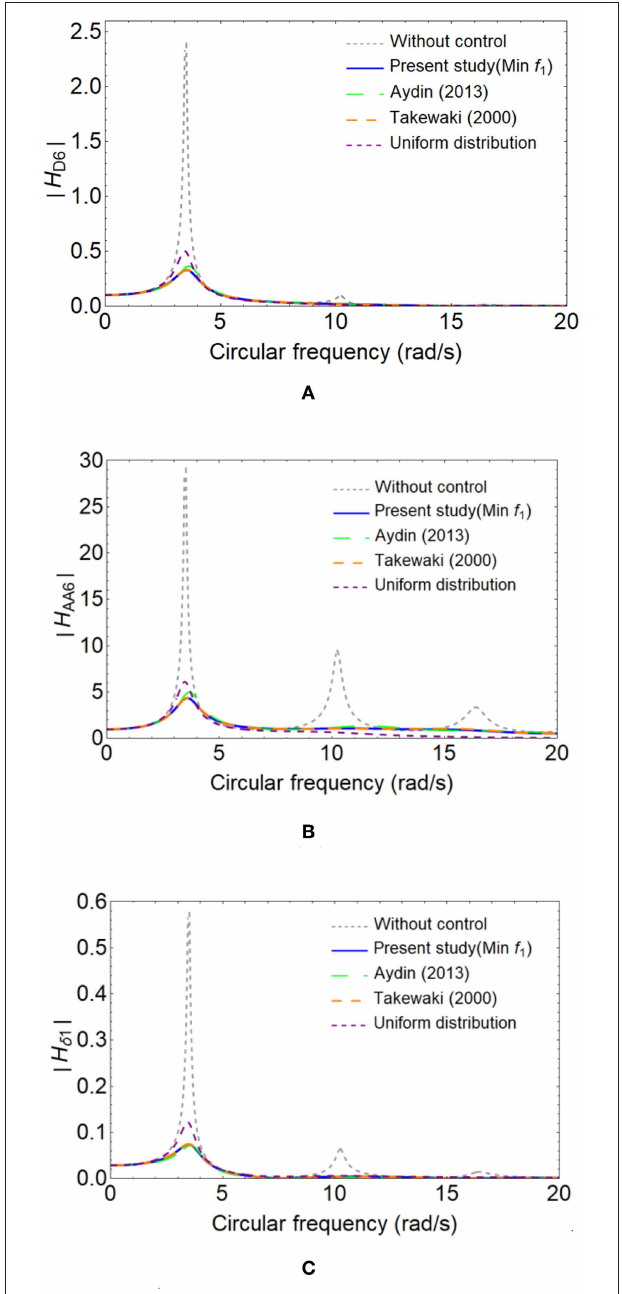
FIGURE 5 | Frequency responses of 6th floor with respect to the transfer function amplitude of top displacement